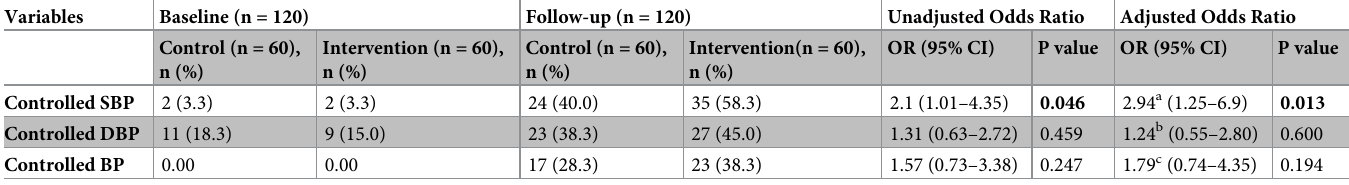
Table 3. Intervention effects on outcome